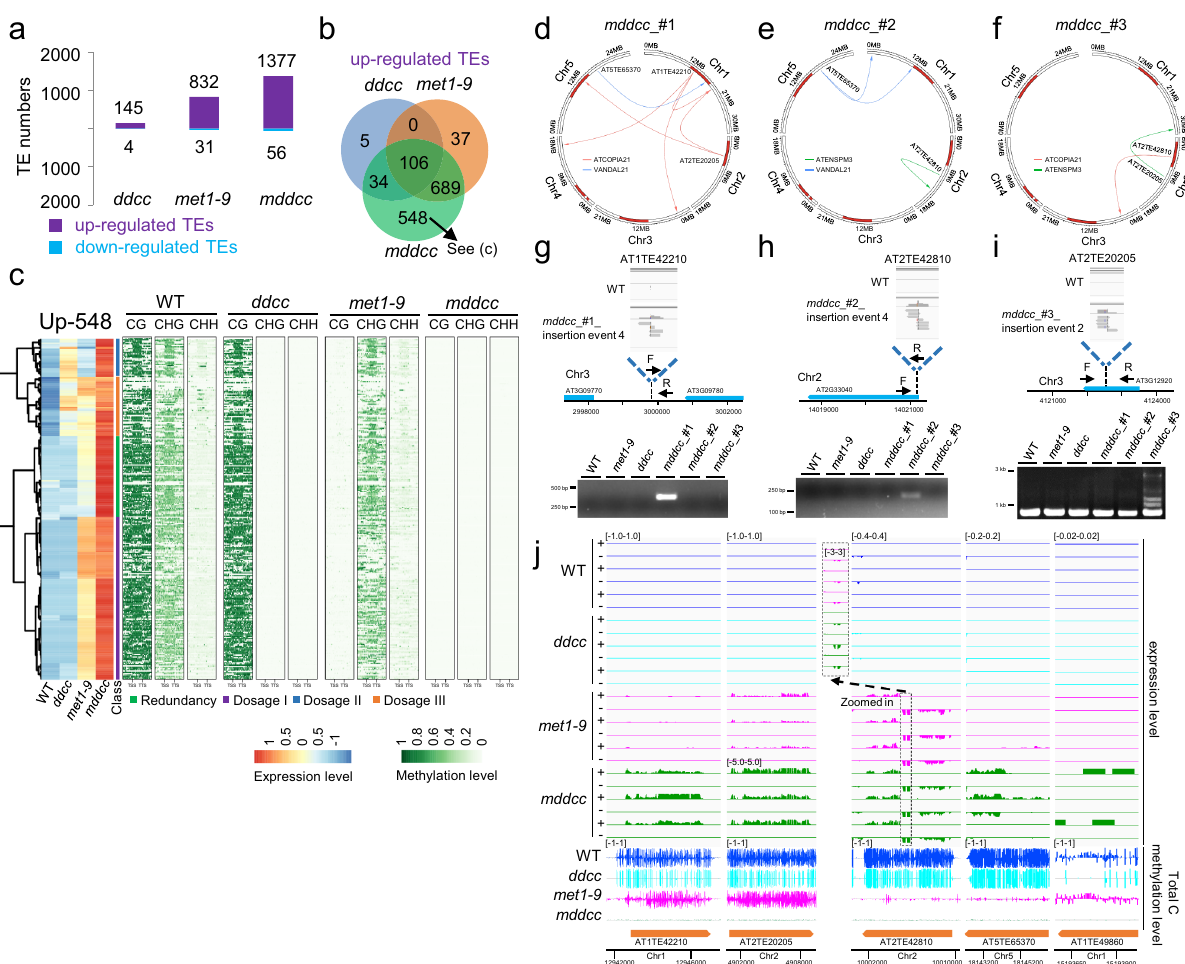
Fig. 3 CG and non-CG methylation jointly repress TE activation and movement. a Number of differentially expressed TEs (DETs) in the indicated mutants relative to WT. b Venn diagram showing the overlap among up-regulated TEs in ddcc , met1-9 , and mddcc mutants. c Heat maps showing the expression and DNA methylation patterns of TEs in the indicated groups. Based on the expression patterns of TEs, TEs were classi fi ed into the following categories: Redundancy, Dosage I, Dosage II, and Dosage III (for details, see Fig. 2e). d – f Circle plots showing TE transposition in different mddcc individual plants. Arrows start and end represent the original and inserted sites of transposed TEs, respectively. The red/green/blue arrows indicate that the transposed TE belongs to the ATCOPIA21, ATENSPM3, or VANDAL21 subfamily, respectively. g – i Products of PCR ampli fi cation with paired primers fl anking new insertion sites or a transposon-speci fi c primer and a primer fl anking the new insertion site in the indicated genotypes. Black arrows indicate primers. Upper panels: screenshots from Integrative Genomic Viewer (IGV) showing split-reads for TE insertions. Lower panels, coordinate lines indicate the sequence contexts of the new insertion sites. j Snapshots of expression and DNA methylation levels over transposed TEs in the indicated mutants. Source data are provided as a Source Data fi